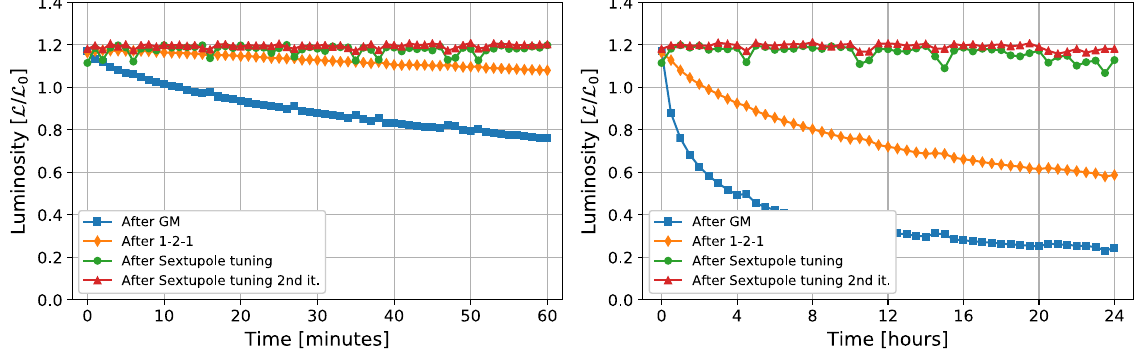
FIG. 11. Left: Luminosity recovery after downtimes up to 60 min. Right: Luminosity recovery for downtimes up to 24 h. We plot the luminosity for the machine misaligned by ground motion, the luminosity after one-to-one steering, and the luminosity after the first and second iterations of scanning the sextupole knobs.